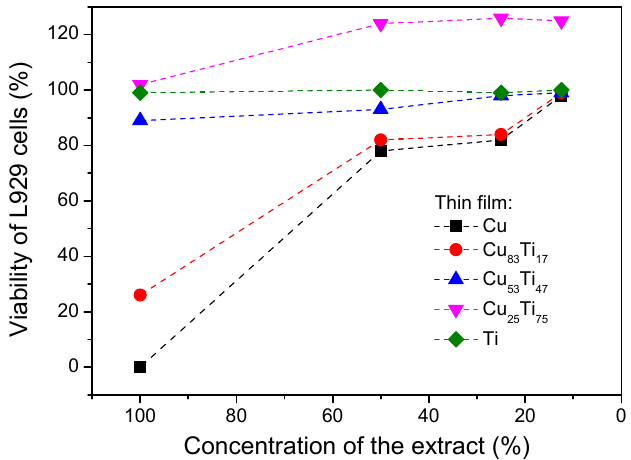
Figure 7. Results of the L929 fibroblast proliferation test in contact with various concentrations of extracts with Cu, Cu-Ti, and Ti thin films after 8 days of